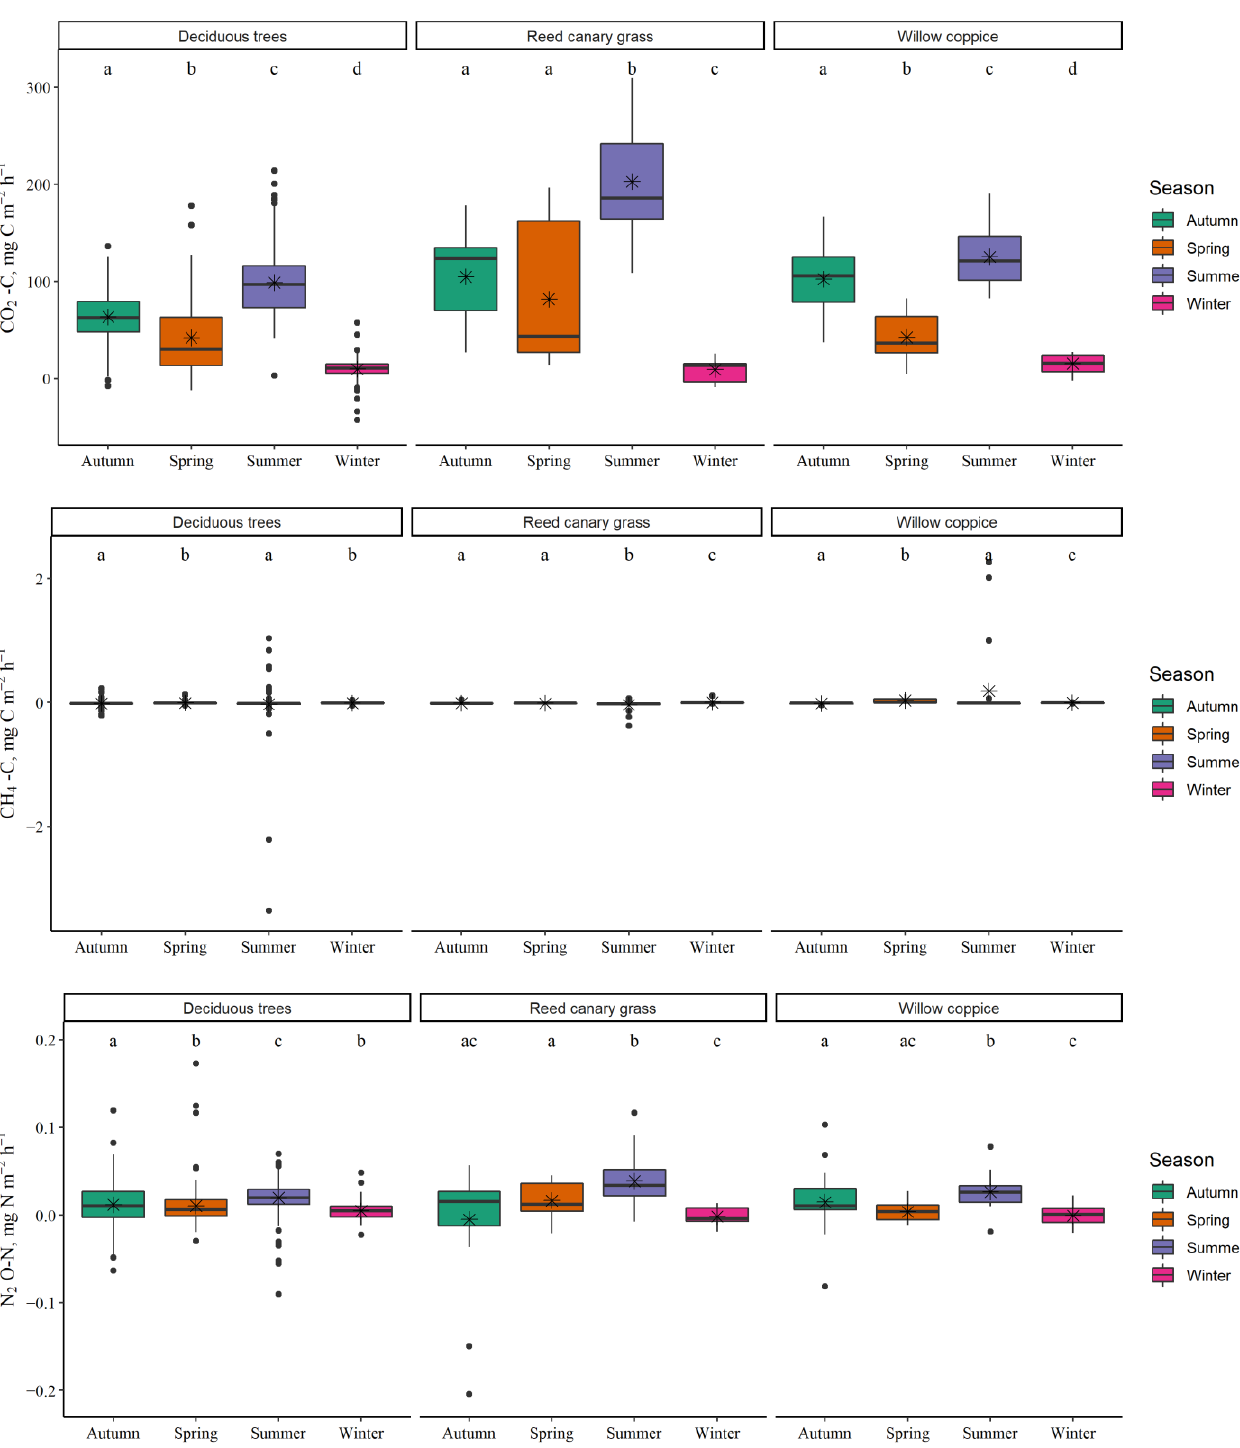
Figure 3. The impact of seasonality on soil GHG fluxes in plots dominated by deciduous trees, willow coppice or RCG in agroforestry systems in hemiboreal Latvia during the measurement period (June 2020–October 2021). In the box plots, the median is shown by the bold line, the mean is shown by the black asterisk, the box corresponds to the lower and upper quartiles, the whiskers show the minimal and maximal values (within 150% of the interquartile range from the median) and the black dots represent outliers of the datasets. Different lowercase letters show statistically significant differences ( p < 0.05) between seasons within the group of dominant vegetation.